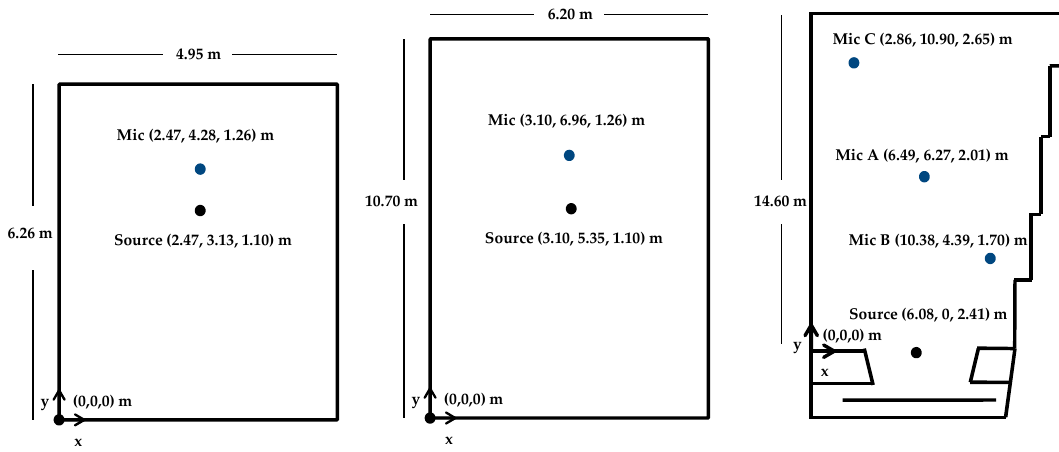
Figure 1. Source and microphone positions for the three spaces with volumes of 88 m 3 , 192.4 m 3 and 1088 m 3 (from left to right ) where measurements were performed.